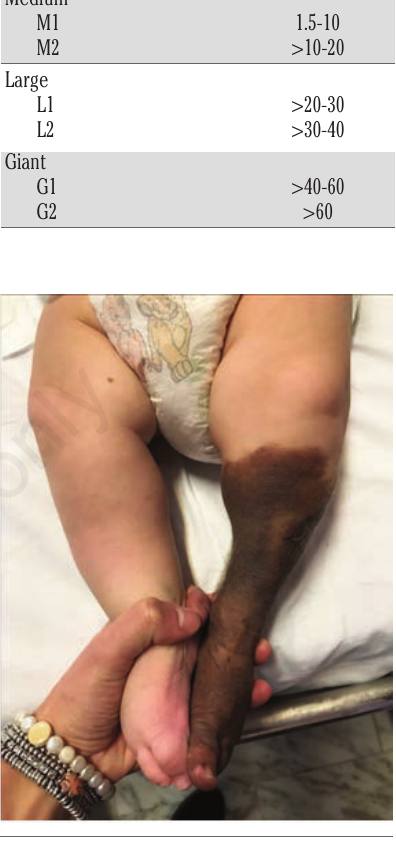
Figure 1. Patient legs. The left leg from the lower portion of the knee to the entire foot is covered by a giant melanocityc nevus. A reduction of the diameter of the left limb in comparison to the right can be also observed, especially in the area of the soleus muscle.